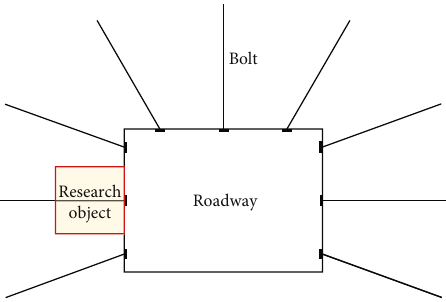
Figure 1: Research object of surrounding rock mass in a